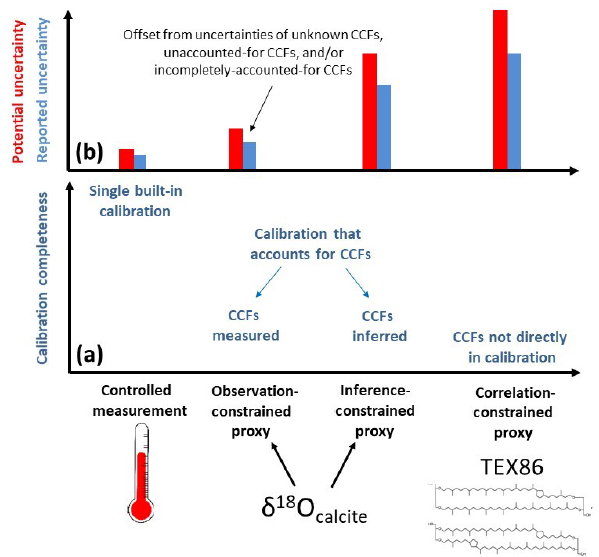
Figure 2. A spectrum ( x axis) of observational measurements as a function of their incorporation of confounding causal factors and re- lated uncertainty. (a) The bottom y axis describes the completeness of a measurement’s calibrations (i.e., how completely a calibration accounts for all causal factors). Controlled measurements on the left have full control of all causal factors. Observation-constrained proxies have a calibration that quantitatively accounts for CCFs and allows the researcher to measure those CCFs. Inference-constrained proxies also have a calibration that quantitatively accounts for CCFs, but the researcher cannot measure the CCFs, so the quantita- tive values for CCFs used in the calibration must be inferred from other evidence. On the right, correlation-constrained proxies have the least direct (quantitative) control of the causal factors, with cal- ibrations that do not quantitatively account for CCFs. (b) The top y axis represents the uncertainty of each measurement, with the red line signifying potential uncertainty and the blue bar showing the range of reported uncertainty in the literature. Because analytical uncertainty varies greatly between proxies, instruments, and users, we have excluded its representation. The arrow and description of offset in panel (a) apply to all